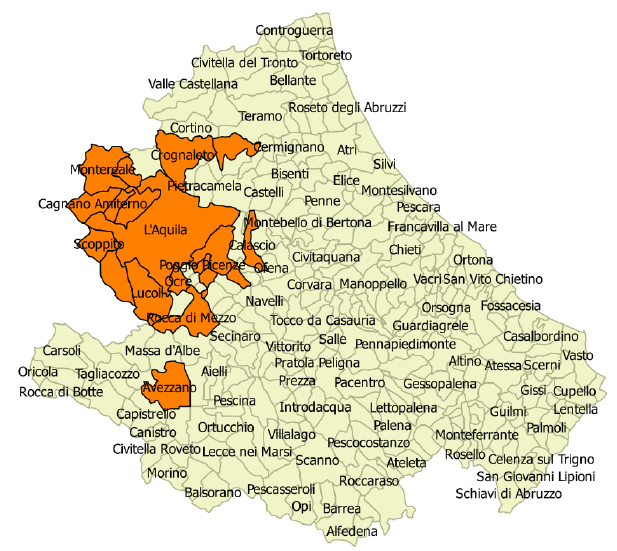
Figure 17. The census of the damaged municipalities (between the first two hours).